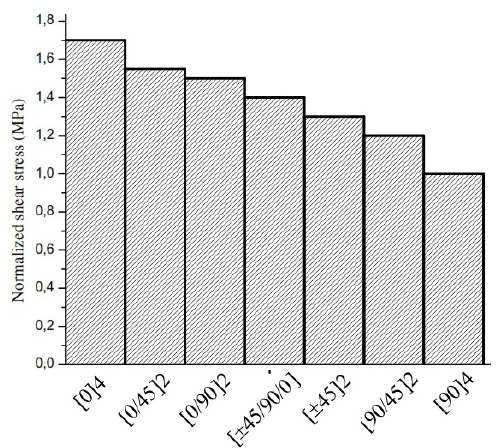
Figure 14. Influence of the patch stacking sequence on the shear stress τ * for a plate [0/45] 2s.